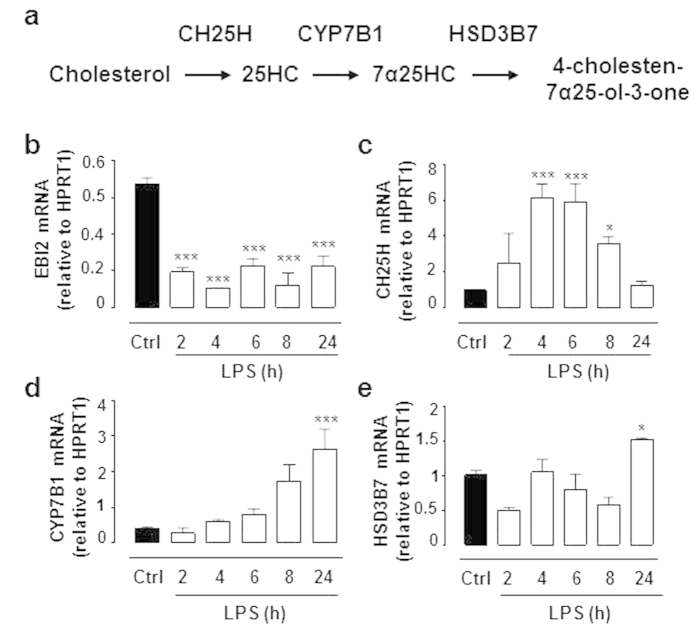
LPS modulates mRNA expression of molecules in the EBI2 signaling pathway in mouse astrocytes.(a) Synthetic and degrading pathway of 7α25HC. (b) Treatment of mouse astrocytes with LPS (100 ng/ml) induces a rapid and lasting suppression of EBI2 mRNA expression. (c) LPS induces CH25H mRNA expression in mouse astrocytes that peaks after four to six hours and declines thereafter. (d) LPS induces a slow and gradual increase in CYP7B1 mRNA expression in mouse astrocytes. (e) LPS induces increase in HSD3B7 mRNA expression after 24 hour treatment. Data presented as mean +/− SEM, n = 3, one-way ANOVA and Dunnett’s post-test, *p < 0.05, ***p < 0.001 vs. corresponding control.